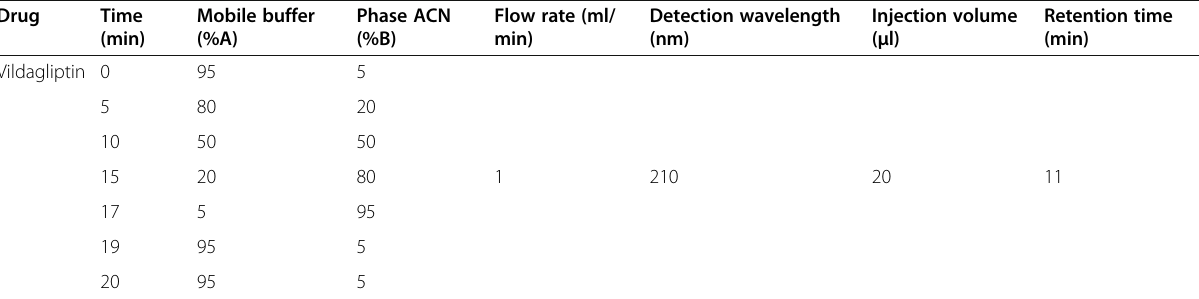
Table 1 Optimized chromatographic conditions for the analysis of vildagliptin by RP-HPLC Drug Time Mobile buffer (min) (%A)